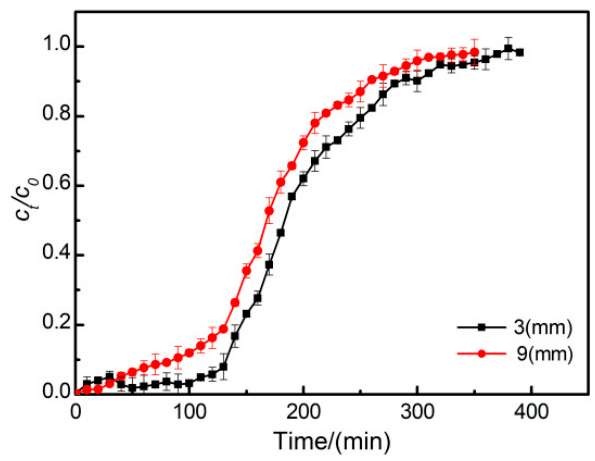
Figure 4. Effects of MBCQ with two particle sizes on the breakthrough curves. Table 3. Effects of MBCQ with two particle si z es on breakthrough time and mass transfer z one length.